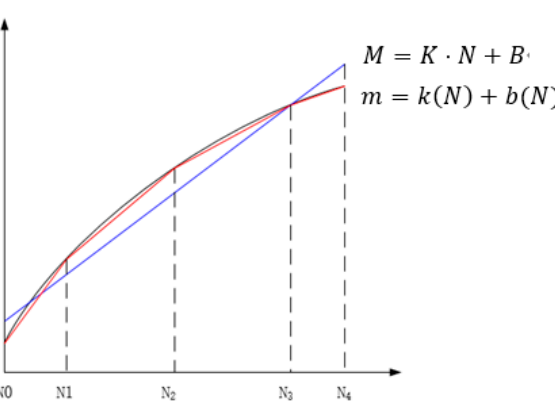
Figure 6. Schematic diagram of sectional correction method (x coordinate: incident light energy; y coordinate: gray value).